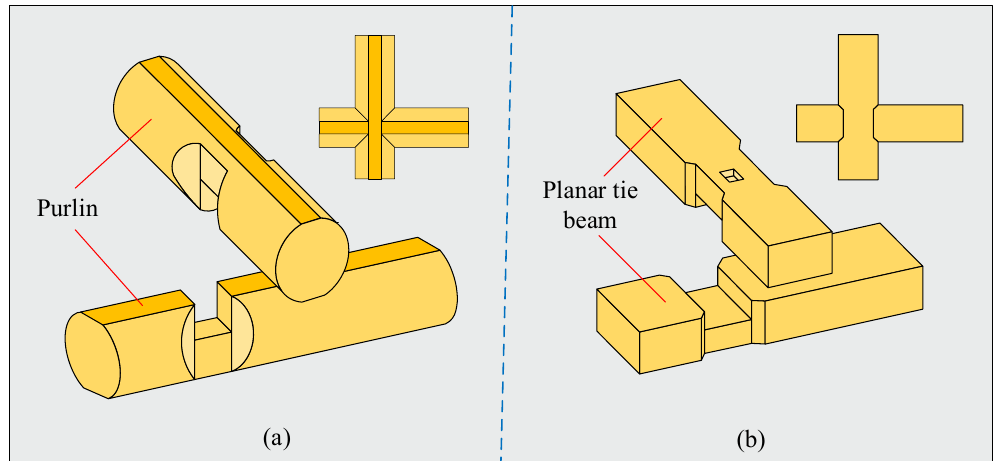
Figure 6. Tenon–mortise joints for joining intersecting horizontal structural components. ( a ) Cross- shaped notched round tenon; ( b ) Cross-shaped notched square tenon.